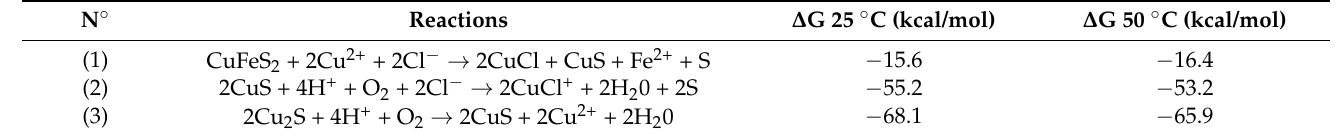
Table 1. Proposed reactions for copper sulphide pretreatment (adapted from [31]). N ◦